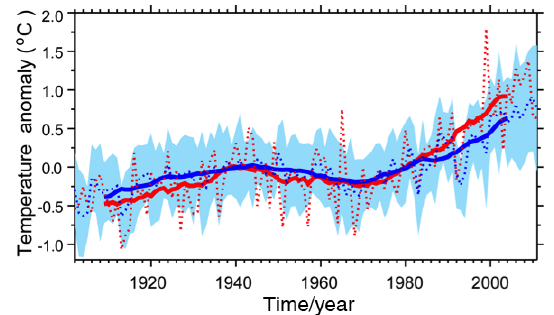
Figure 12. Time series of radiatively forced temperature (red) and ensemble-mean CMIP5 simulations (blue) based on a 15-year run- ning mean in the cold season from 1902 to 2011 over east Asia. The blue shading indicates the standard deviation of the CMIP5- simulated field.